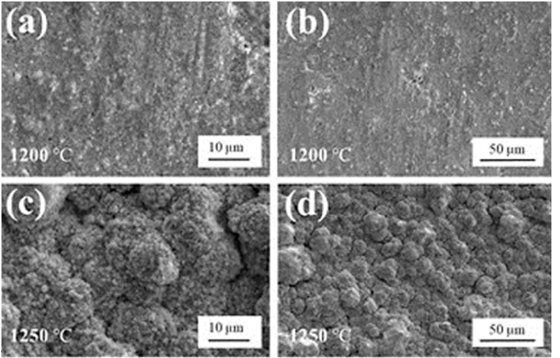
Figure 3. Surface morphology of HfO 2 coatings prepared at different deposition temperatures. ( a )